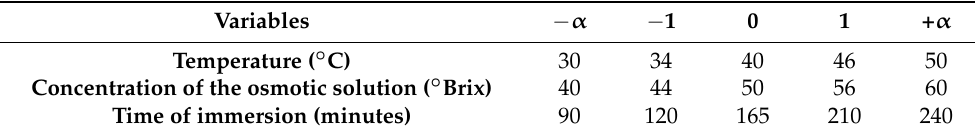
Table 1. Coded and decoded levels of independent variables. Variables − α − 1 0 1 + α Temperature ( ◦ C) 30 34 40 46 50 Concentration of the osmotic solution ( ◦ Brix) 40 44 50 56 60 Time of immersion (minutes) 90 120 165 210